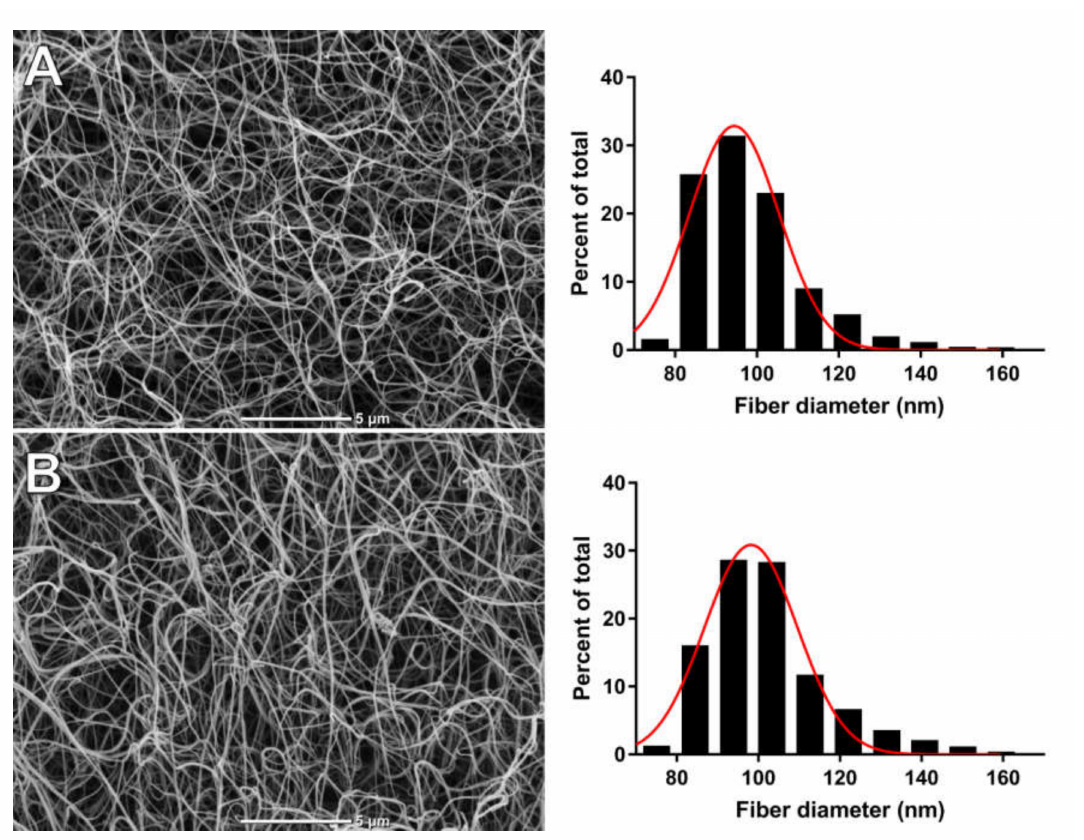
Figure 2. Representative scanning electron microscopy images of fibrin mesh with histograms for fibrin diameters in AS patients with: ( A ) the highest total protein carbonyl level (defined as the top quartile, > 3.05 nmol / mg); and ( B ) lower PC levels ( < 3.05 nmol / mg).